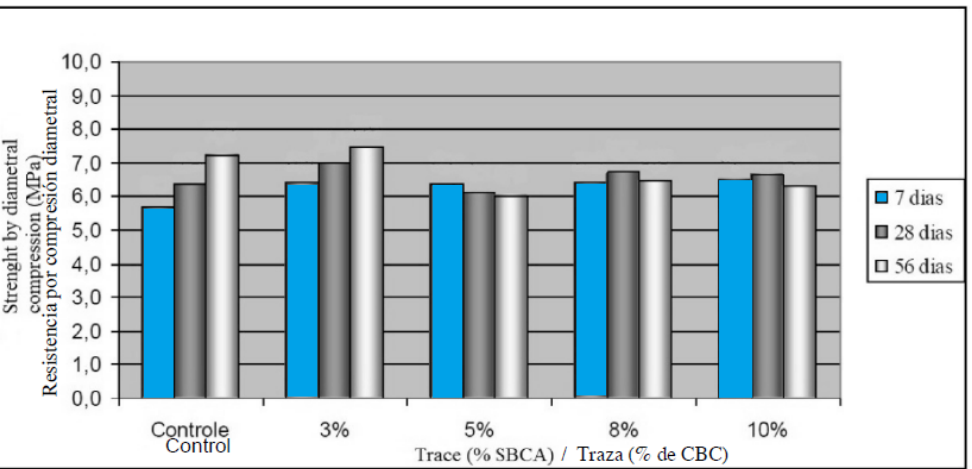
Figure 6. Tensile strength by diametral compression [28]. (Translation: 7 dias is 7 days, 28 dias is 28 days, and 56 dias is 56 days).